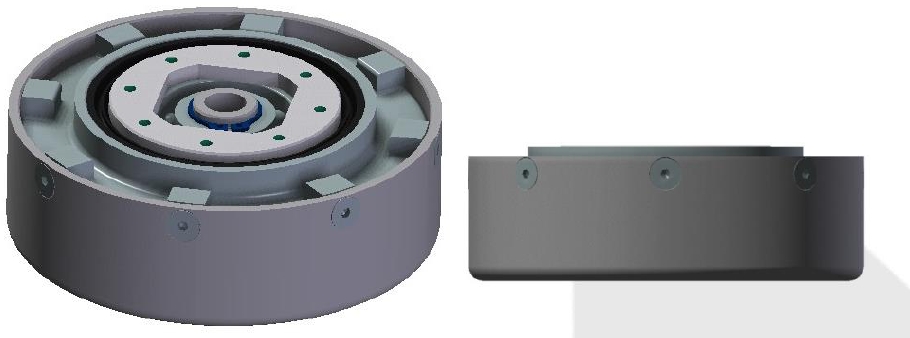
Figure 2. Design of the magnetic torque limiter.